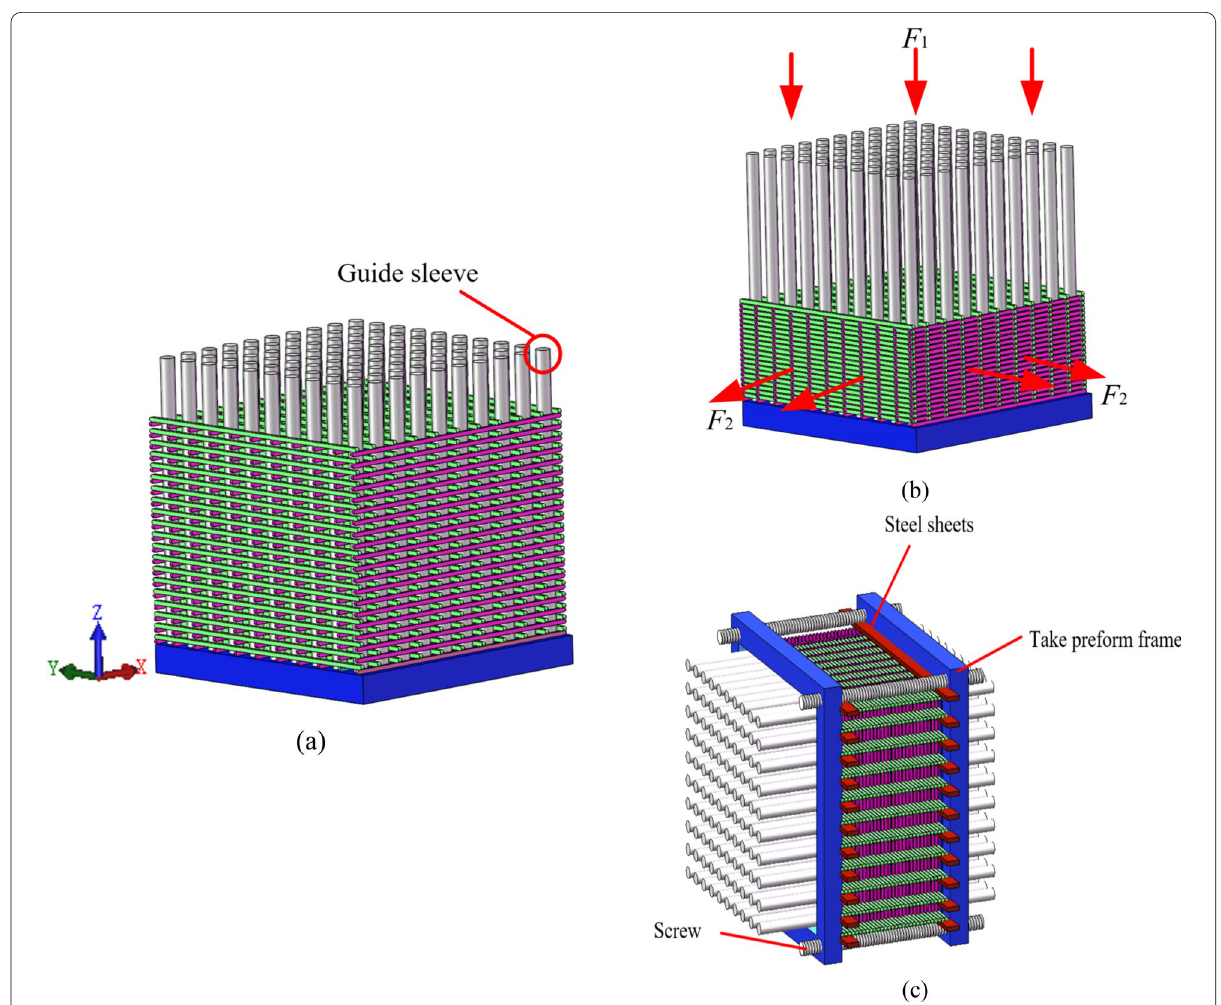
Figure 8 Force on guide